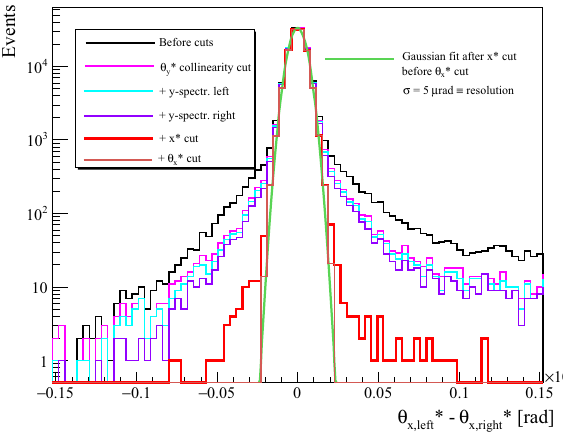
θ * - θ * [rad] x,left x,right